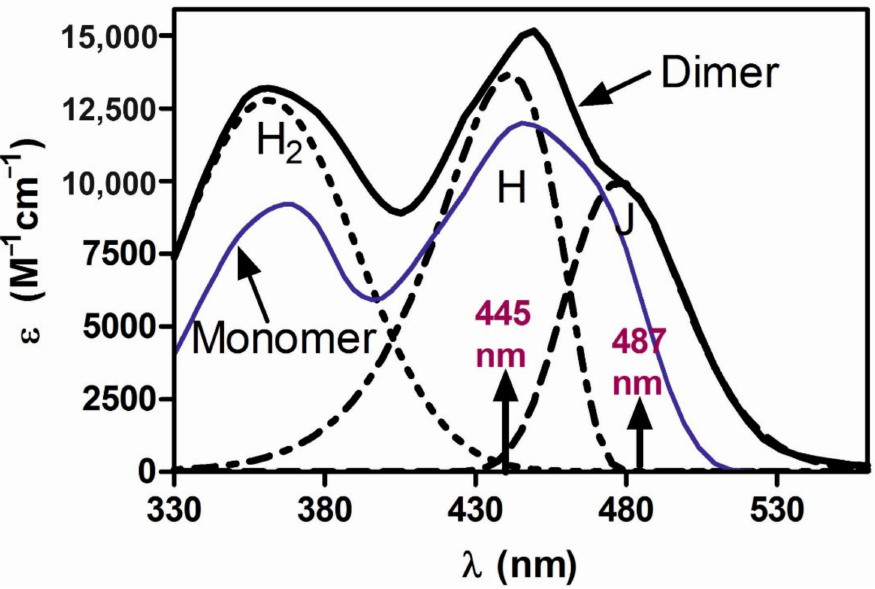
Figure 1. Monomer (blue line) and dimer ((black line) absorption spectra of FMN in PVA films (dimer spectrum is calculated per dimer unit). The H and J band components of the dimer absorption spectrum were calculated from log-normal distribution of dimer absorption spectra: H and J are bands corresponding to the S 1 ← S 0 transitions in monomeric units in the dimer, while H 2 band corresponds to the transition S 2 ← S 0 (spectra reconstructed from Grajek [34], with permission from Wydawnictwo